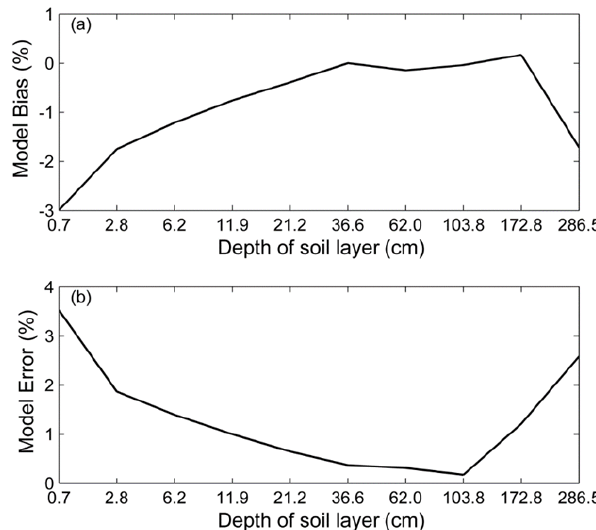
Figure 3. The areal average of the model’s bias (a) and error (b) for one step in the soil moisture content between the CoLM and the CLM 4.0. The horizontal axis represents the layer